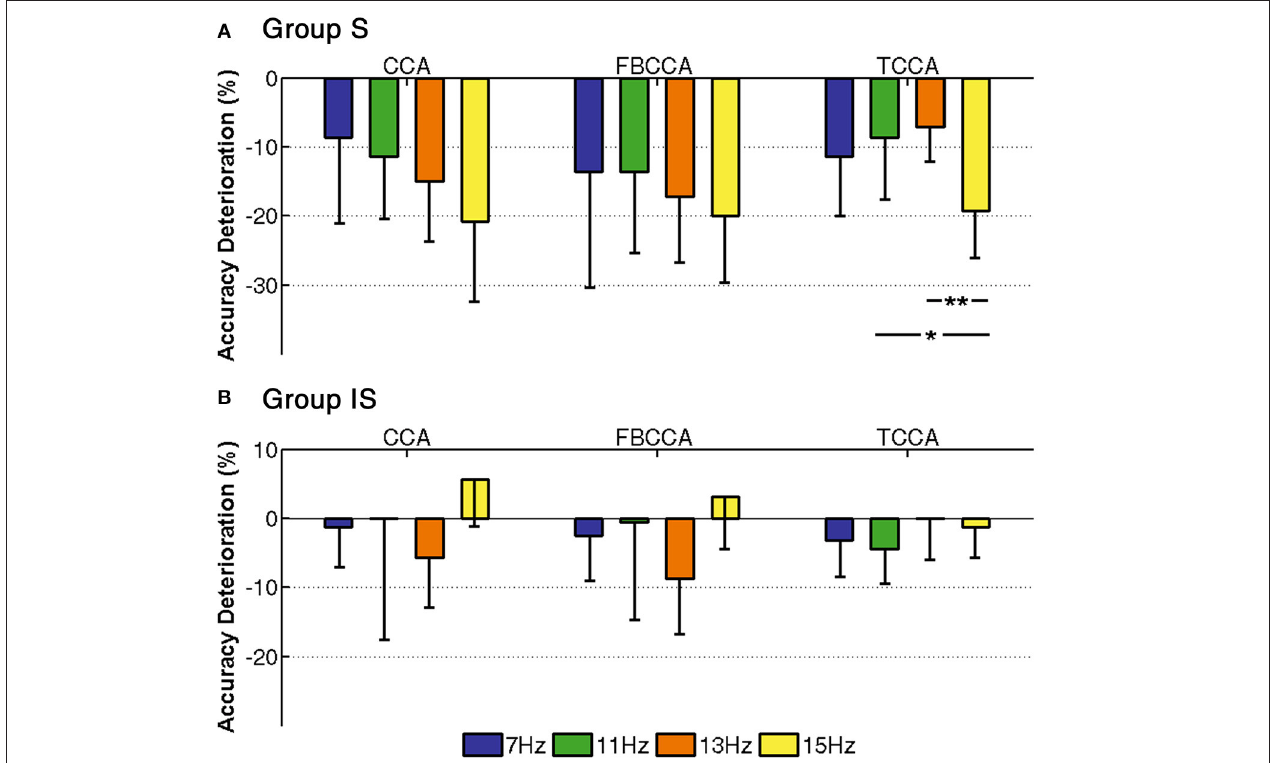
FIGURE 4 | Deterioration of classification accuracy from 1- to 4-back with a data length of 3s for each frequency. The error bars represent standard deviations across subjects and asterisks represent significant differences between two frequencies (* p < 0.05, ** p < 0.01). (A) Group S. (B) Group